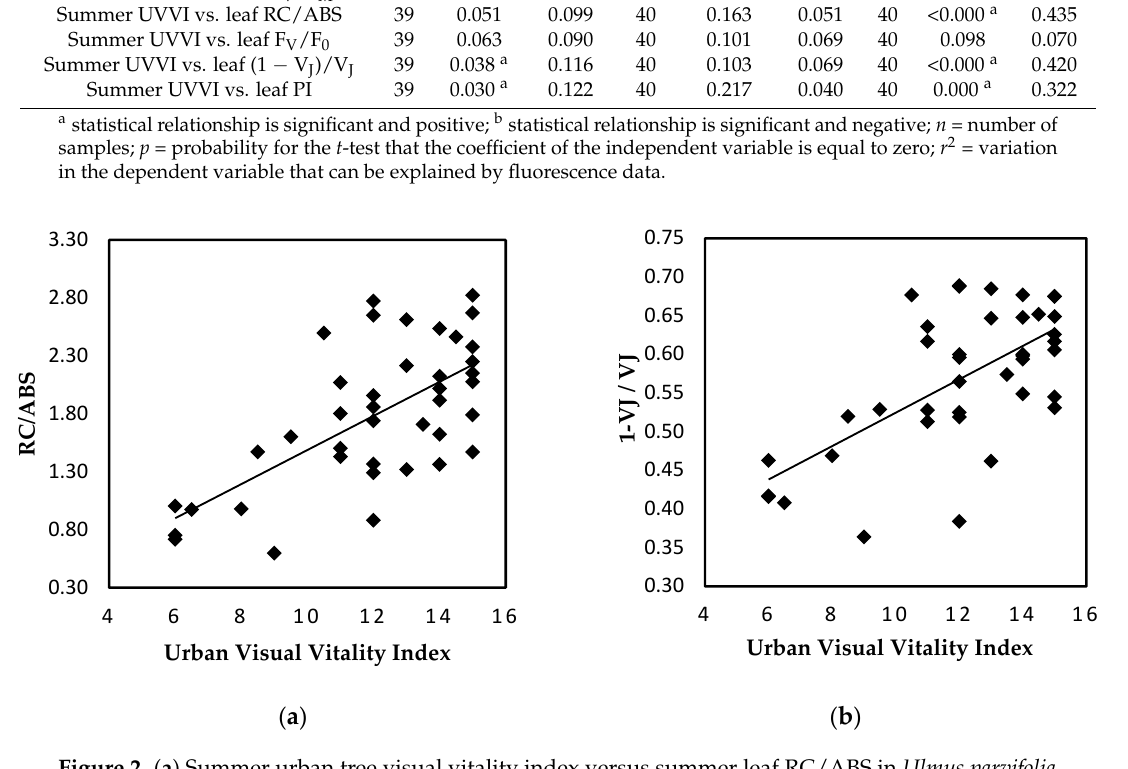
Figure 2. ( a ) Summer urban tree visual vitality index versus summer leaf RC/ABS in Ulmus parvifolia . Trend line = linear regression, p < 0.000, r 2 = 0.435, n = 40. ( b ) Summer urban tree visual vitality index versus summer leaf (1 – Vj)/Vj in Ulmus parvifolia . Trend line = linear regression, p < 0.000, r 2 = 0.420, n = 40.